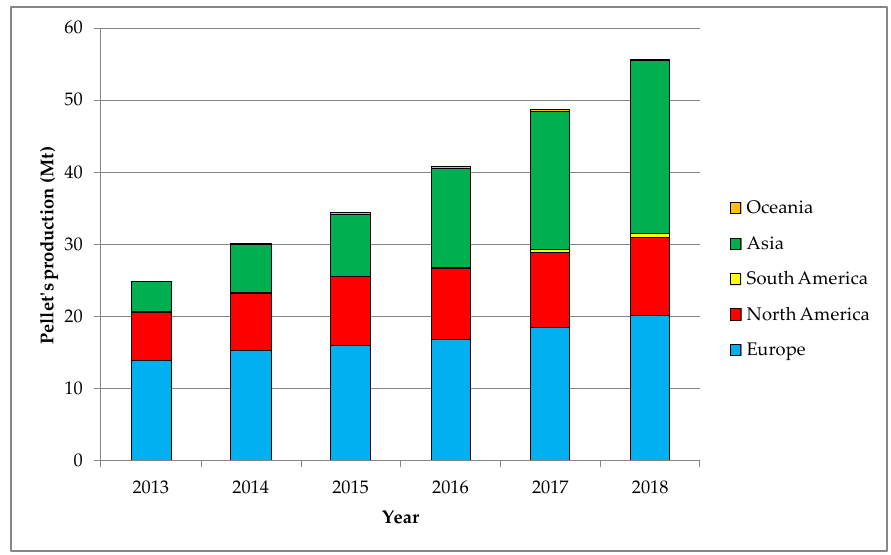
Figure 1. Worldwide pellet production from 2013 to 2018 [14].